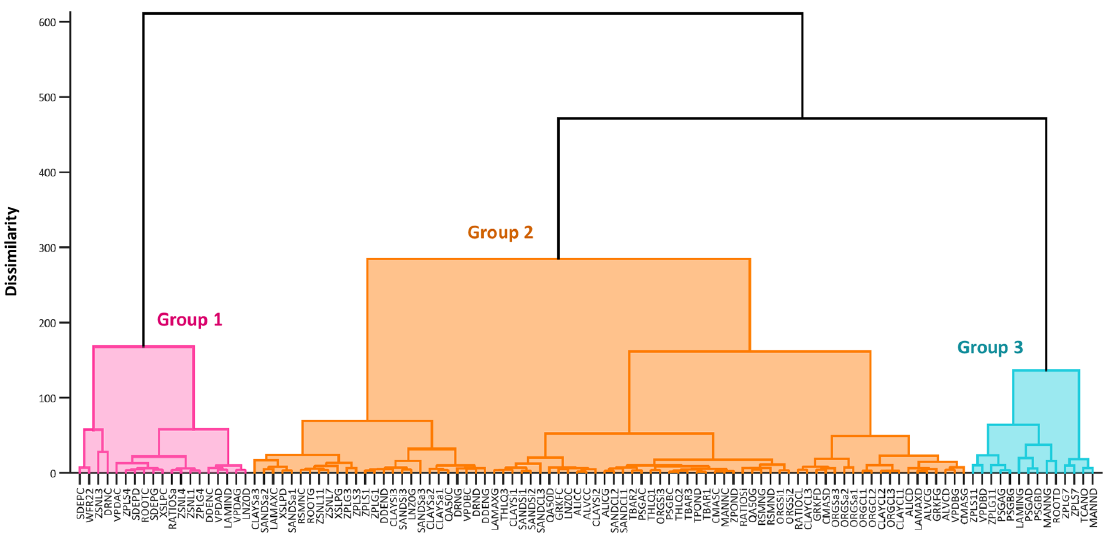
Figure 10. Grouping of the 111 parameters of the MESH model. The parameters are sorted from the most influential (to the left) to the least influential (to the right). This grouping is based on the results of the RBF method.